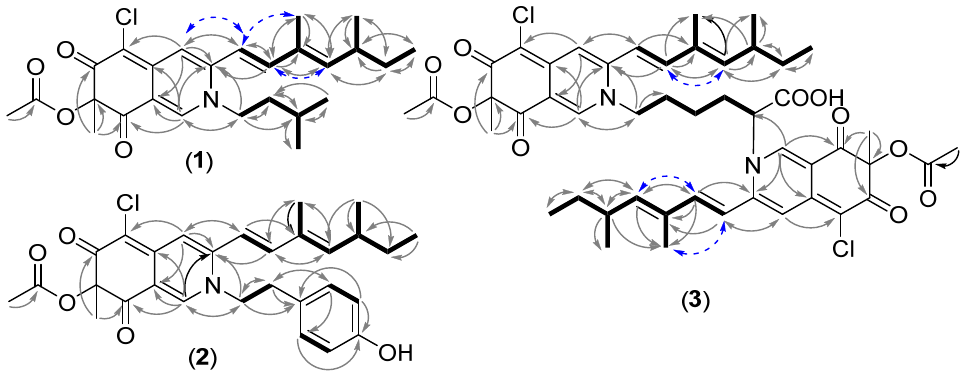
Figure 2. COSY (bold), HMBC (arrow) et NOESY (blue dashed arrow) correlations of penazaphilones J–L ( 1 – 3 ).